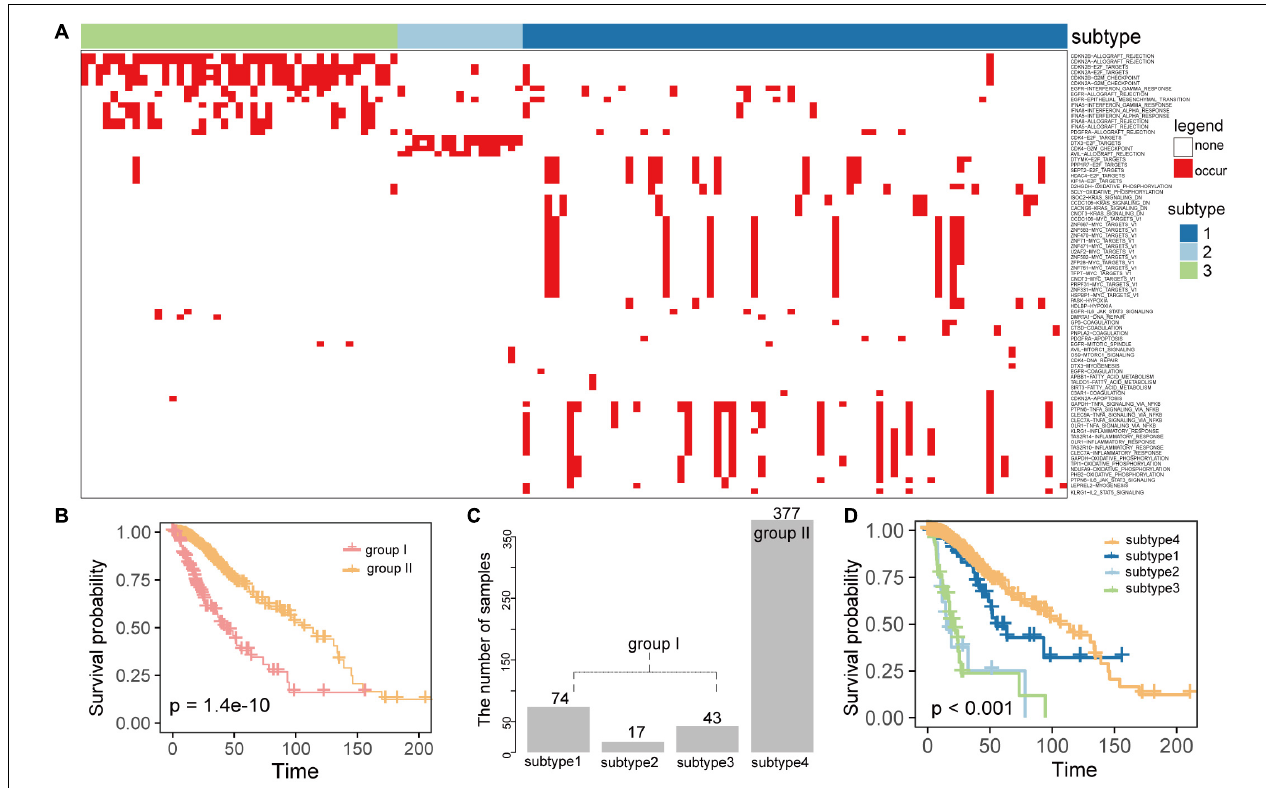
FIGURE 4 | The gene-hallmark pairs identified were associated with LGG prognosis and characterize new subtypes. (A) The heatmap of gene-hallmark pairs contained 81 gene-hallmark pairs across 134 cancer samples for three subtypes; (B) comparison of survival time between the two groups with (group I) or without (group II) gene-hallmark pairs; (C) the bar plot showed the number of samples contained in each subtype; (D) the Kaplan–Meier analysis of subtypes identified by our method based on OS. P -value was calculated by the log-rank test among subtypes.